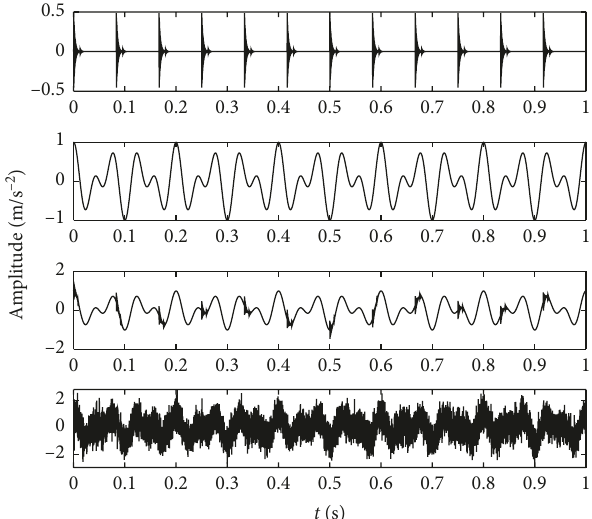
Figure 2: Simulation signal of early fault of the